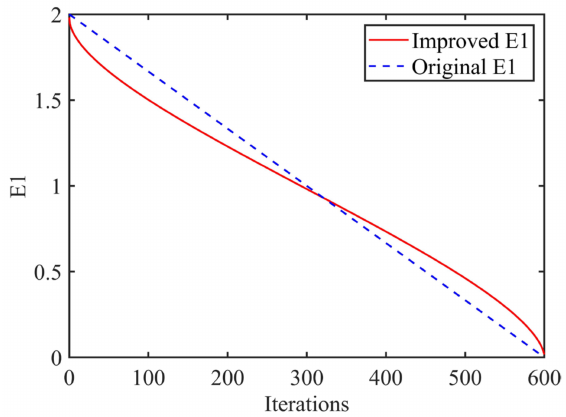
Figure 4. Curves of improved E 1 and original E 1